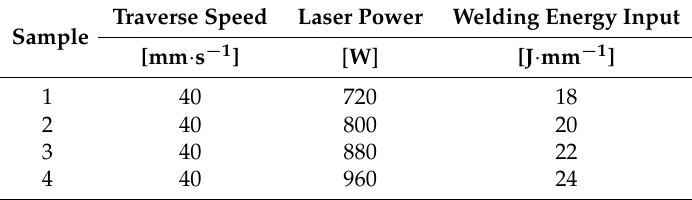
Table 2. Experimental design and parameters for each of the investigated materials.